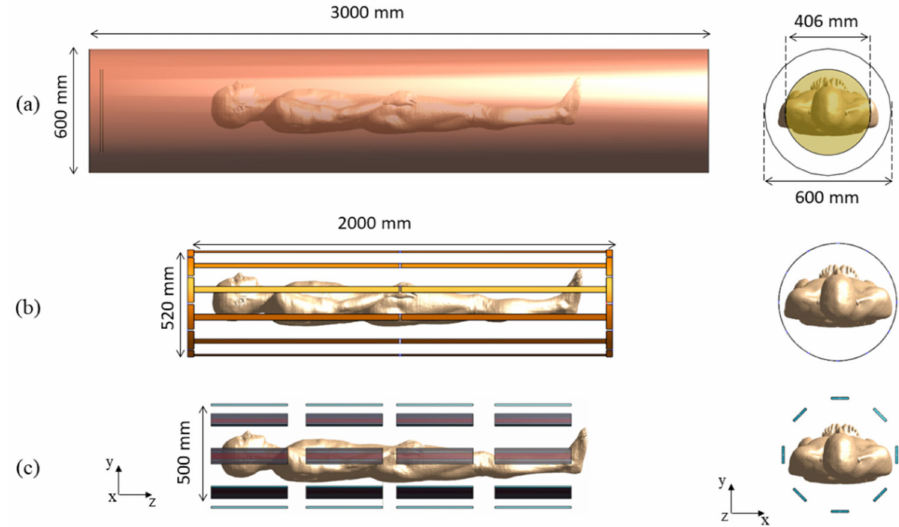
Figure 6. The geometry of each of the array configurations for the whole body in sagittal and axial views, for the ( a ) path antenna, ( b ) birdcage coil, and ( c ) t-MTL